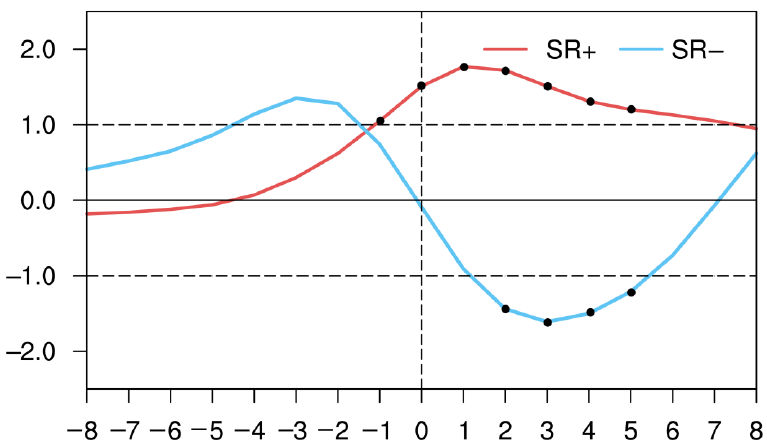
Figure 8. Daily normalized domain-averaged temperature anomalies during the SRP+ and SRP− events from day −8 to day 8 in the YRV (114–122° E, 27–32° N); The solid circles indicate that the anomalies are statistically significant at the 0.05 confidence level.